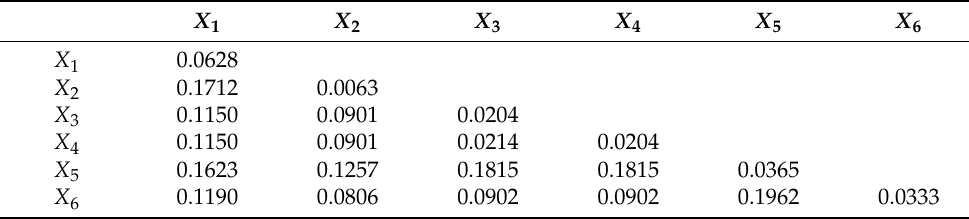
Table 6. Interaction detection